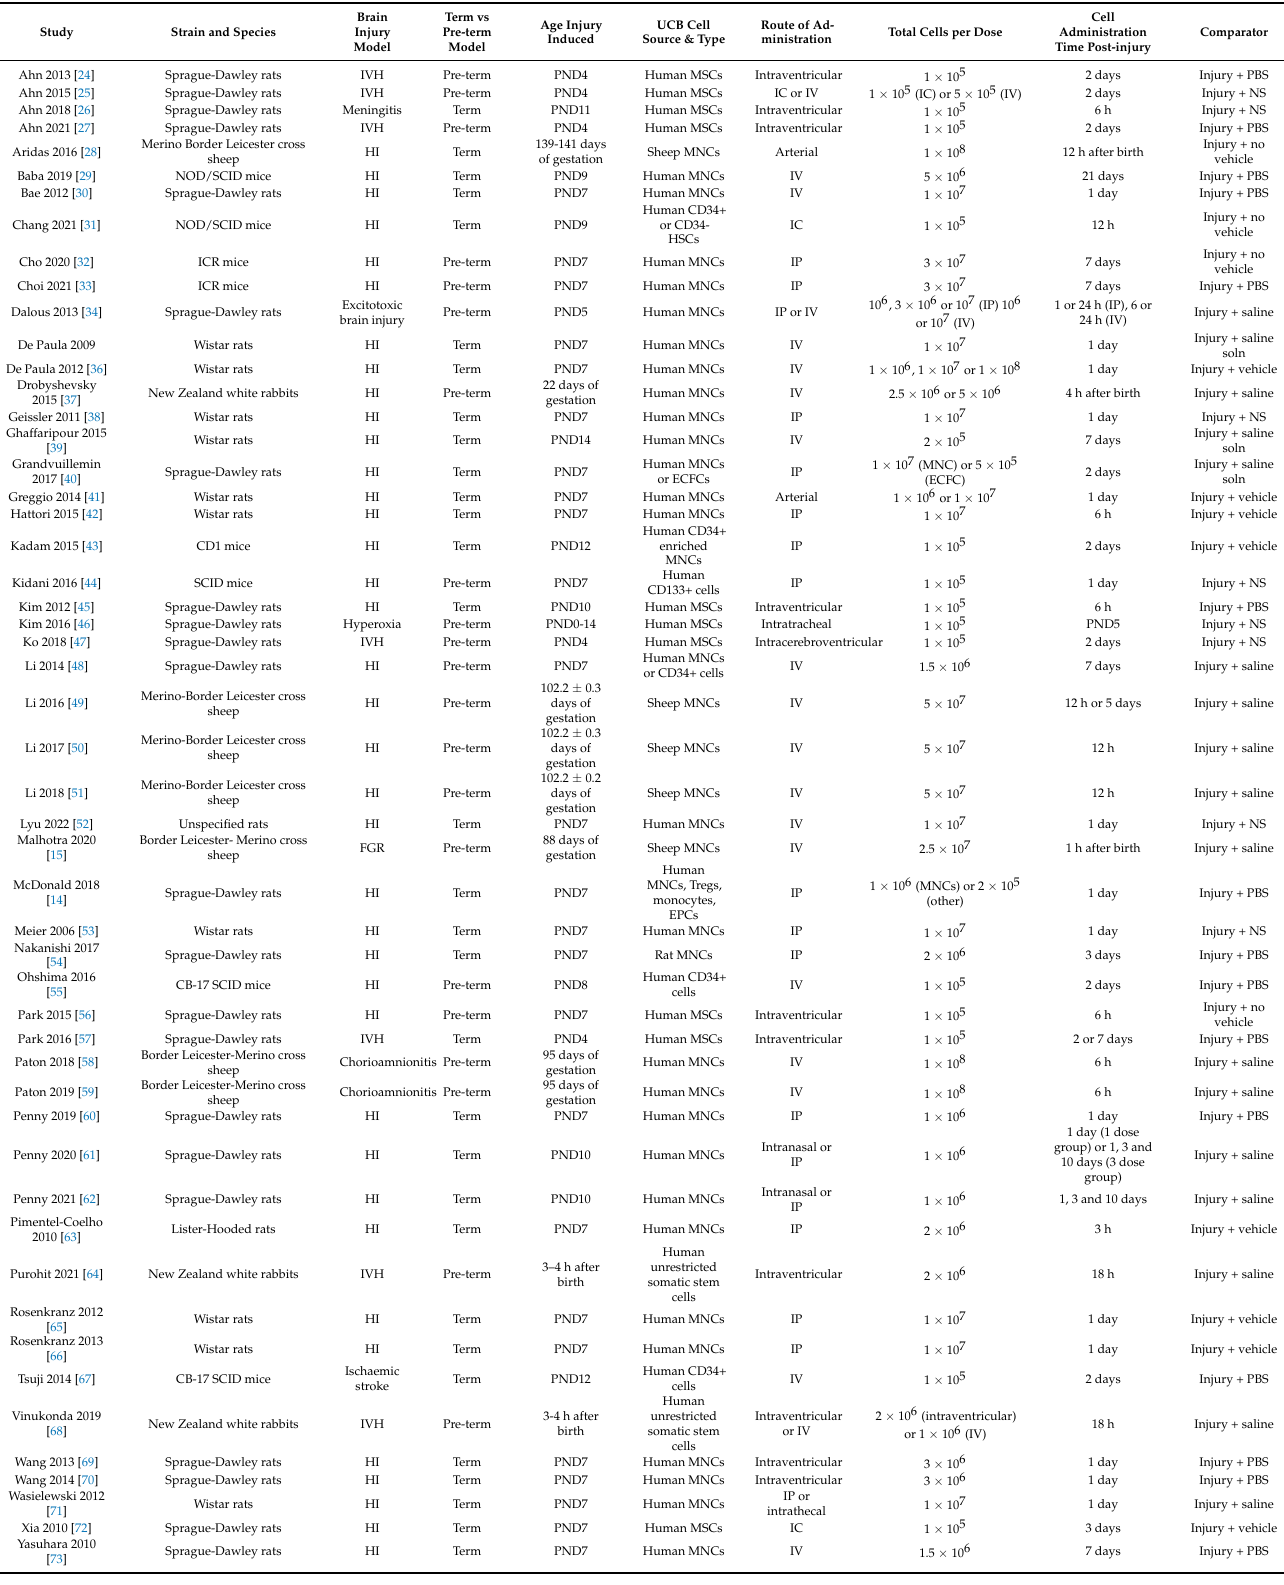
Table 1. Characteristics of included